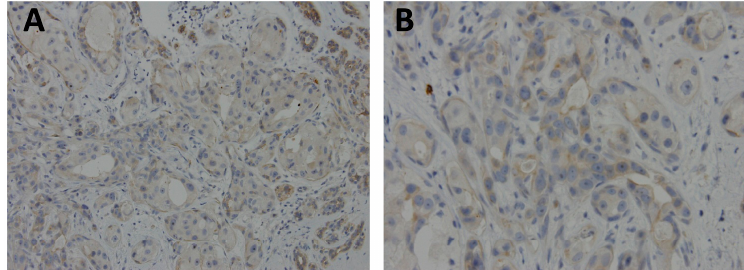
Figure 2. Representative case of archival, paraffin-embedded breast ductal carcinoma stained with polyclonal GPER1 antibody (Sigma-Aldrich, 1:50 dilution) showed focal, weak membranous and cytoplasmic expression. ( A , original × 200, and B , original × 400).